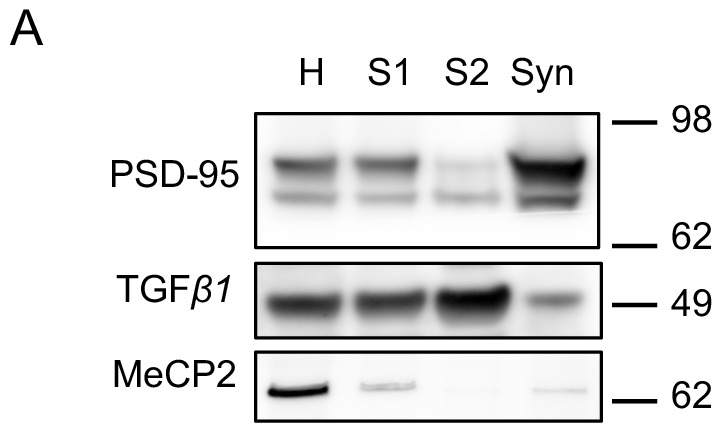
Validation of synaptosomes preparation.(A) Immunoblot analysis of fractions derived from different steps of synaptosomal preparation. Synapse specific protein PSD-95 showed enriched signal in purified synaptosomes as expected. Somatic protein TGF-β1 is enriched in the cytosolic fraction S2. Nuclear protein MeCP2 is barely detectable in S1, S2 or Syn. H: homogenate. S1 and S2 are successive supernatants in the synaptosomal preparation protocol. S2 is also the cytosolic fraction. Syn: synaptosomes.